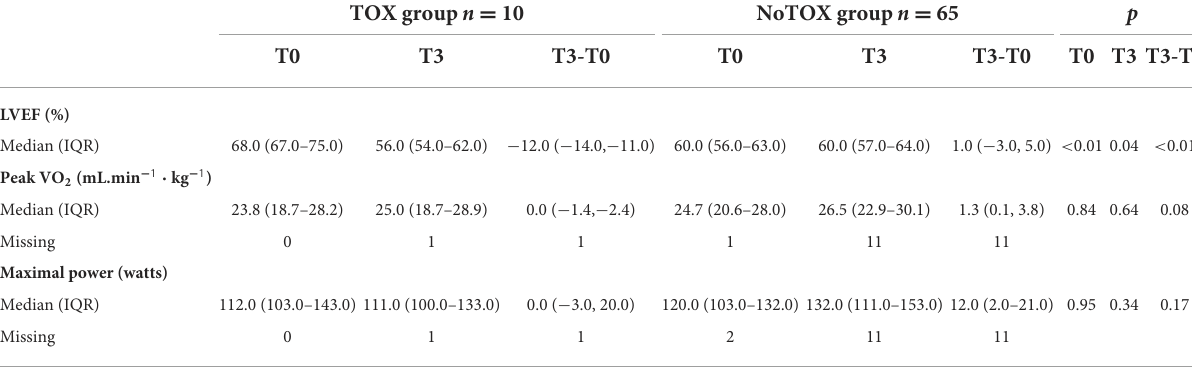
TABLE 6 Subgroups analysis in patients who presented cardiotoxicity (TOX group) or not (NoTOX